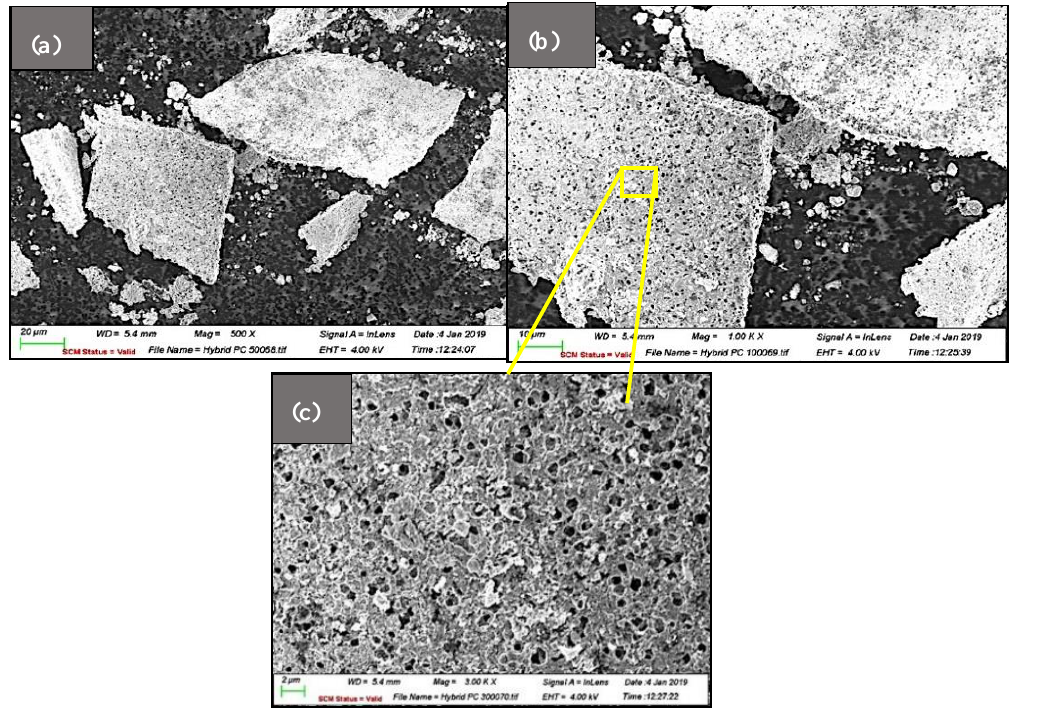
Figure 3. SEM images of the ZnO-MoS 2 hybrid photocatalyst ( a ) at 500 × ; ( b ) at 1000 × ; ( c ) magnified porous surface at 3000 ×.